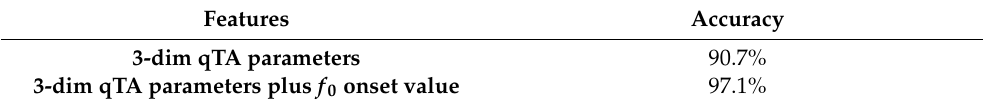
Table 7. Tone recognition rates using qTA (quantitative target approximation) features.